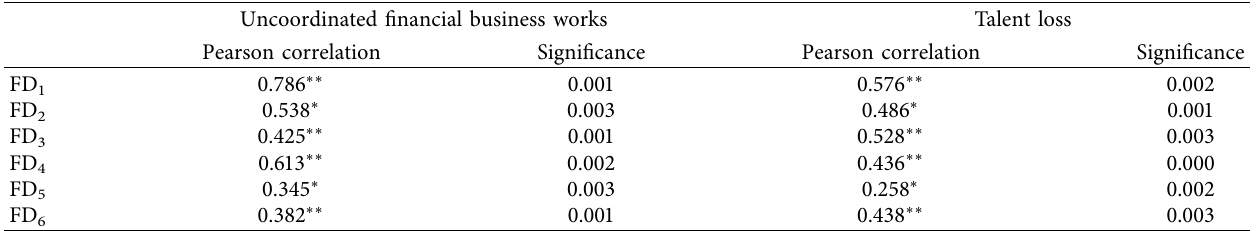
Table 2: Correlation analysis of frst-level evaluation indexes and diferent types of fnancial distress–Part 2. Uncoordinated fnancial business works